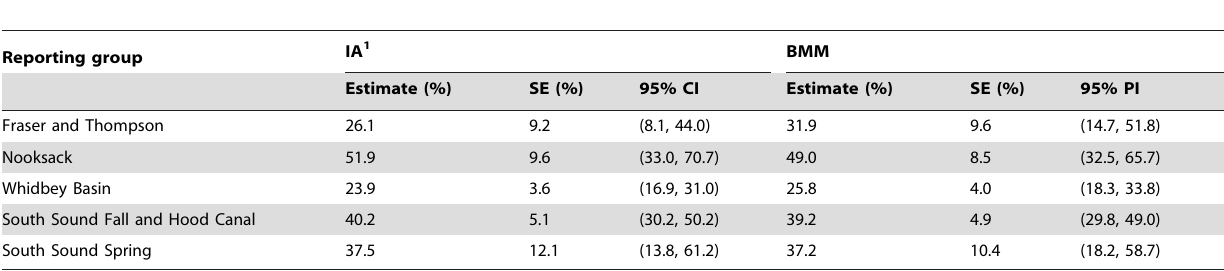
Table 5. Estimates of stock-specific BKD prevalence in Puget Sound Chinook salmon population groups from two different methods, with standard errors (SE), and either 95% confidence or probability intervals (CI or